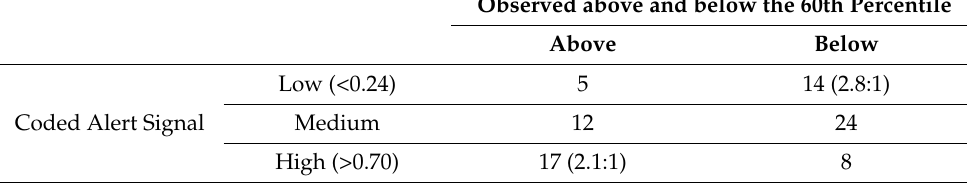
Table 3. Summary of numbers of coded alert signals when ESBL-producing E. coli observed above and below the 60th percentile (January 2015–December